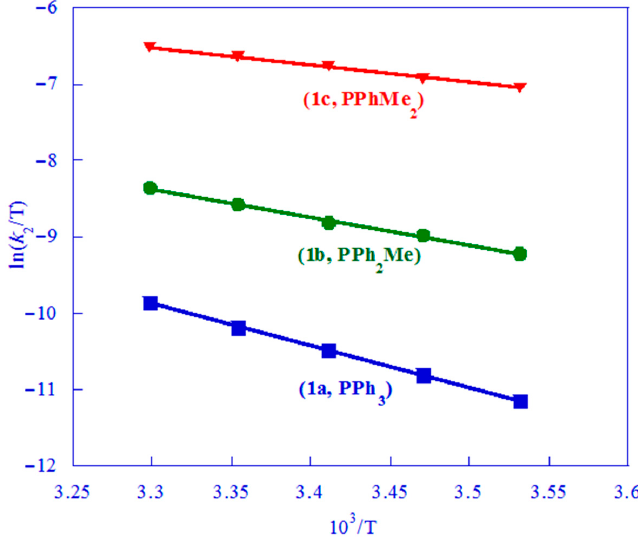
Figure 5. Eyring plots for the reactions of 1a , 1b [76] and 1c with MeI in